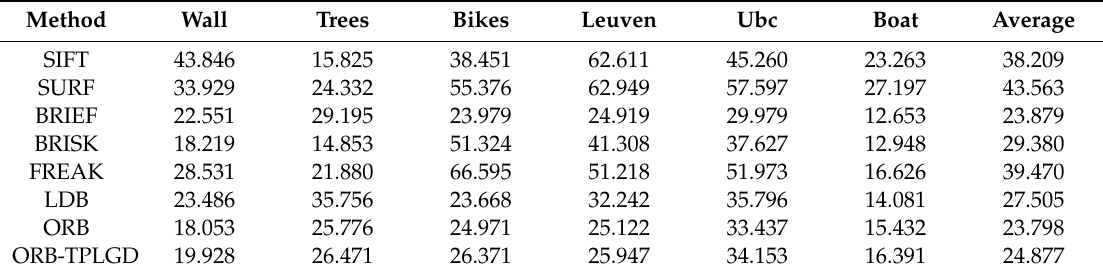
Table 5. Average matching recall based on Oxford dataset (%).